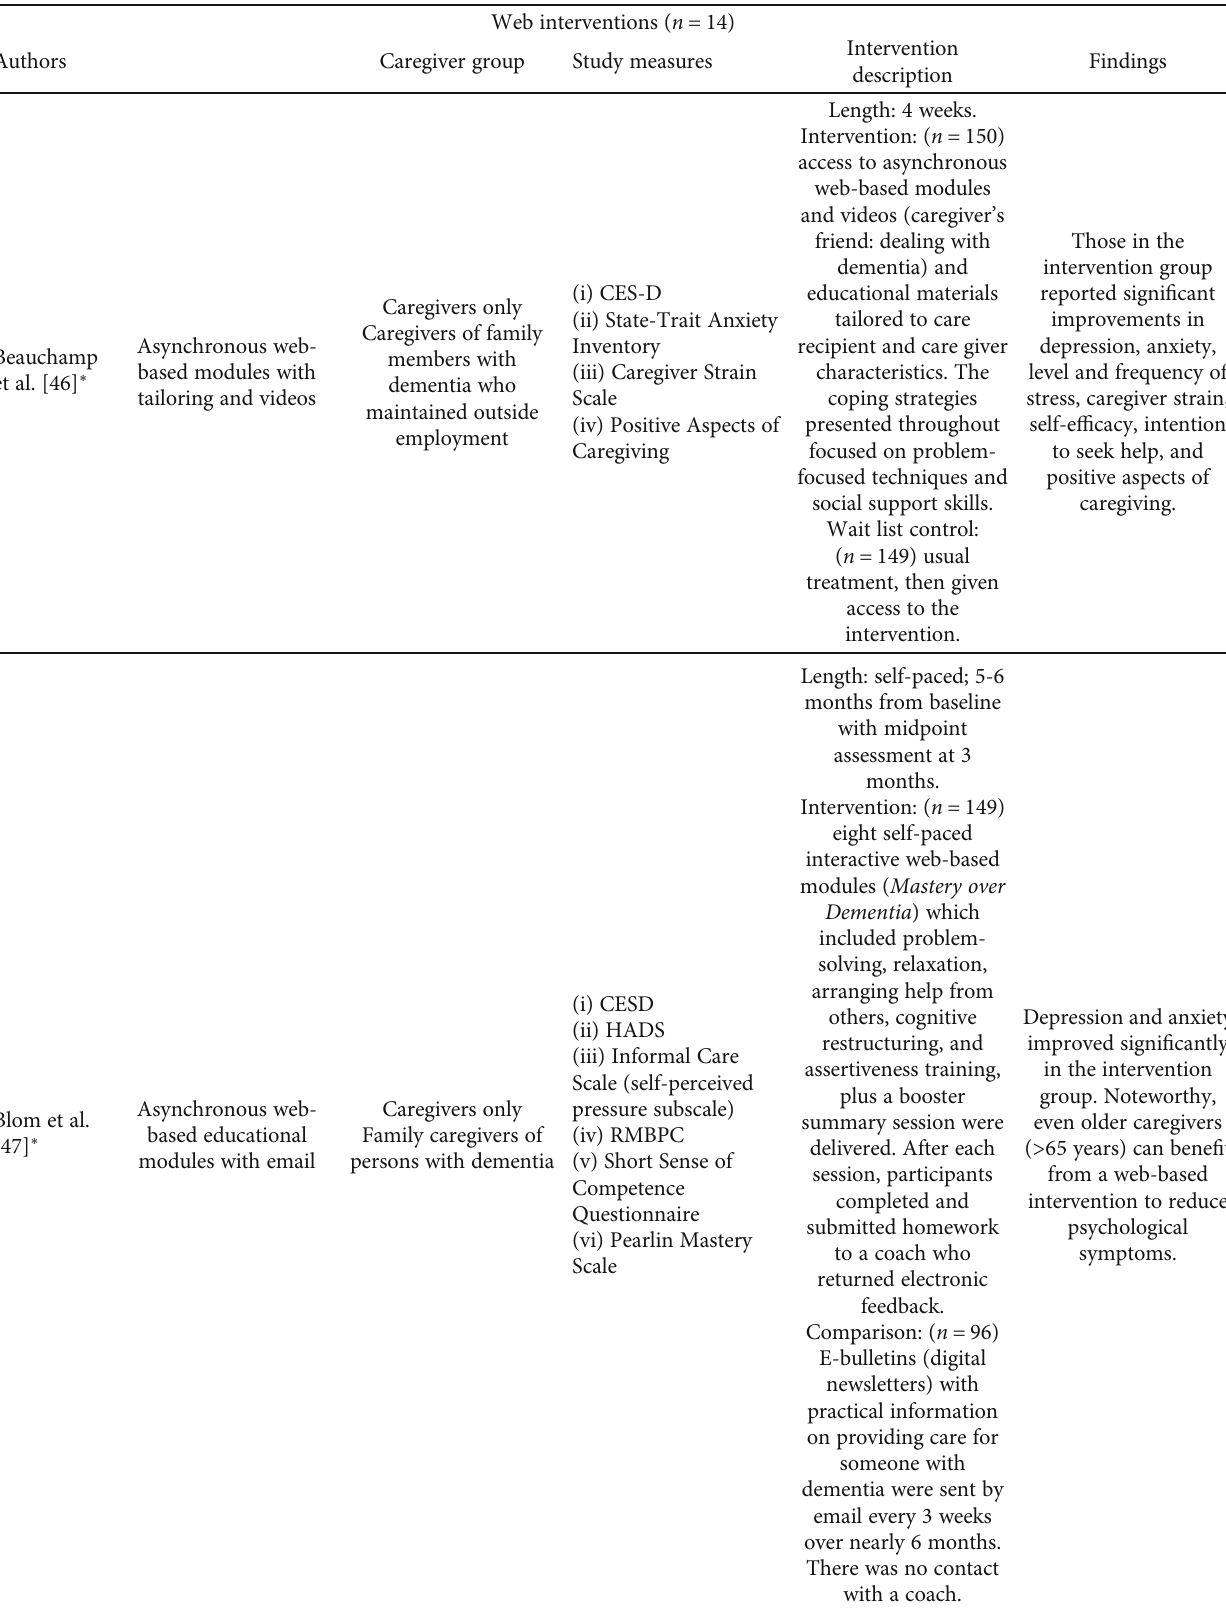
Table 4: Web interventions for caregivers of persons with chronic health